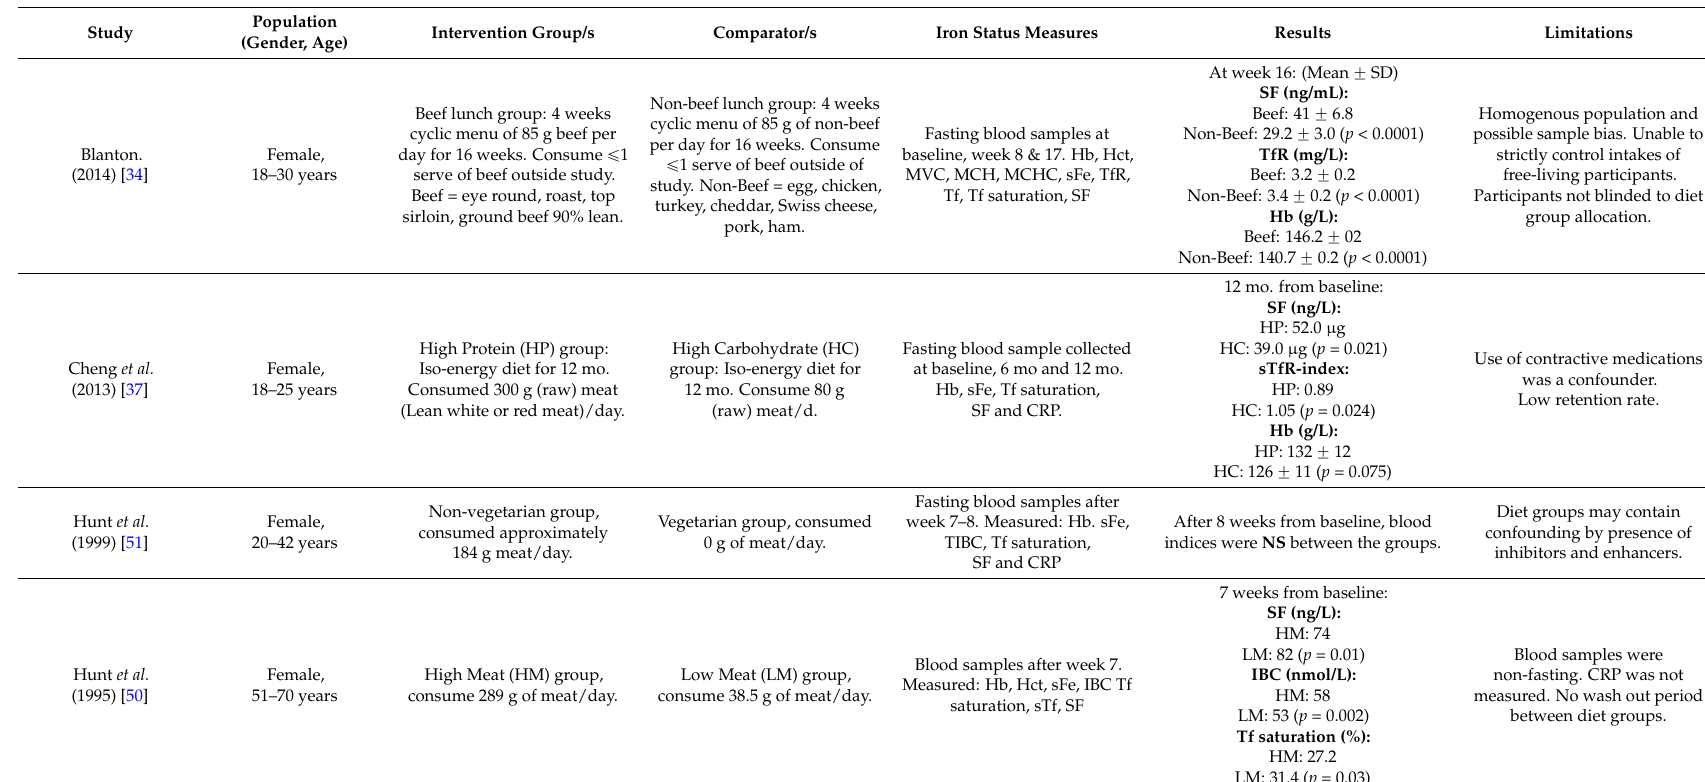
Table 1. Experimental results: Intake of animal flesh foods and iron